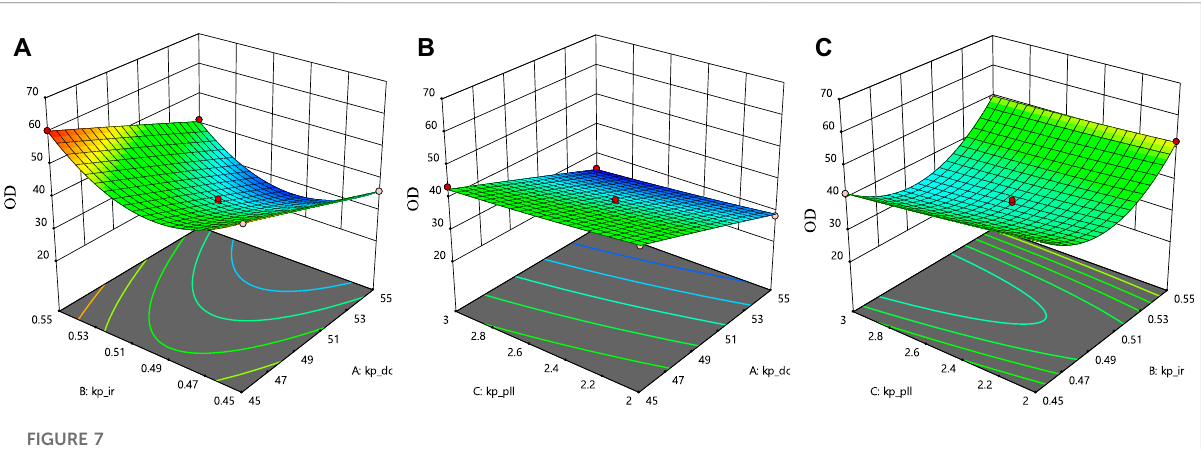
FIGURE 7 Effect of factors on OD . (A) Effect of k p dc and k p ir on OD ; (B) Effect of k p dc and k p pll on OD ; (C) Effect of k p ir and k p pll on OD